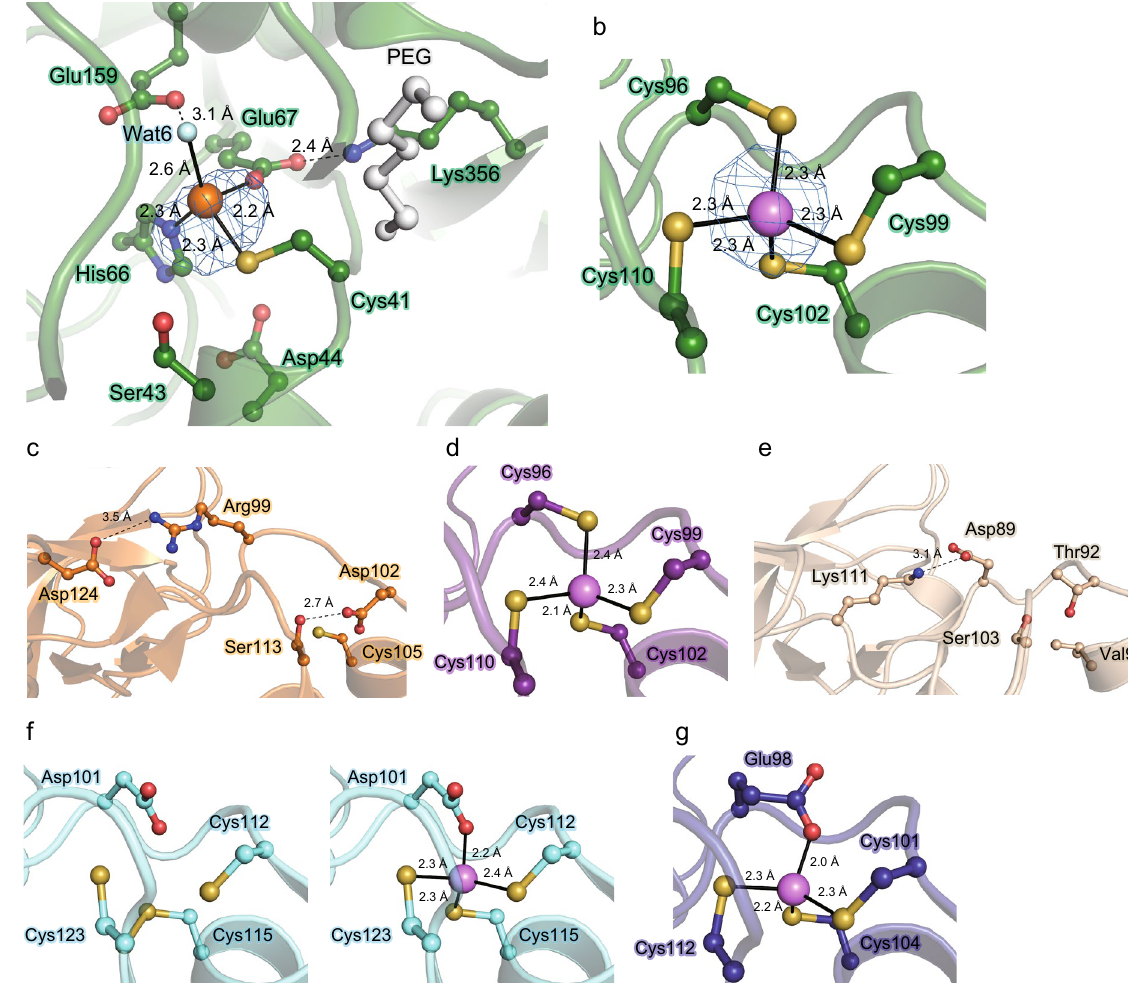
Figure 5. Zinc binding in the PsXDH C4 mutant. ( a ) Amino acid residues involved in chelating the catalytic zinc atom in the active site, together with some neighboring residues. PEG is derived from crystallization solution. Anomalous difference Fourier maps, contoured at 3.0 σ and 10 σ, suggest peaks for the catalytic zinc ( a ) and structural zinc atoms ( b ), respectively, and are shown as a blue mesh. ( b ) Structural zinc binding sites, and comparisons with SDH from human (1PL6) ( c ), SDH from silverleaf whitefly (1E3J) ( d ), and ADHs from T. brockii (1YKF) ( e ), A. pernix (1H2B) ( f ), and S. solfataricus (1JVB) ( g ). In ( f ), there are two structures in the presence of zinc (right panel) and in its absence showing the disulfide bond (left